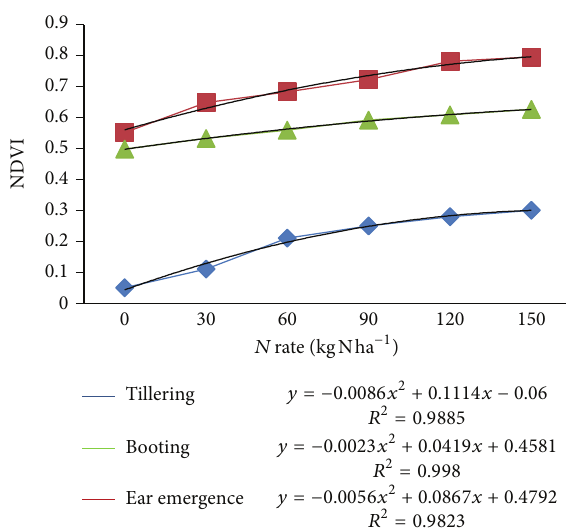
Figure 8: Relation between NDVI values calculated from N-sensor data for different N-treatments at different crop growth stages.